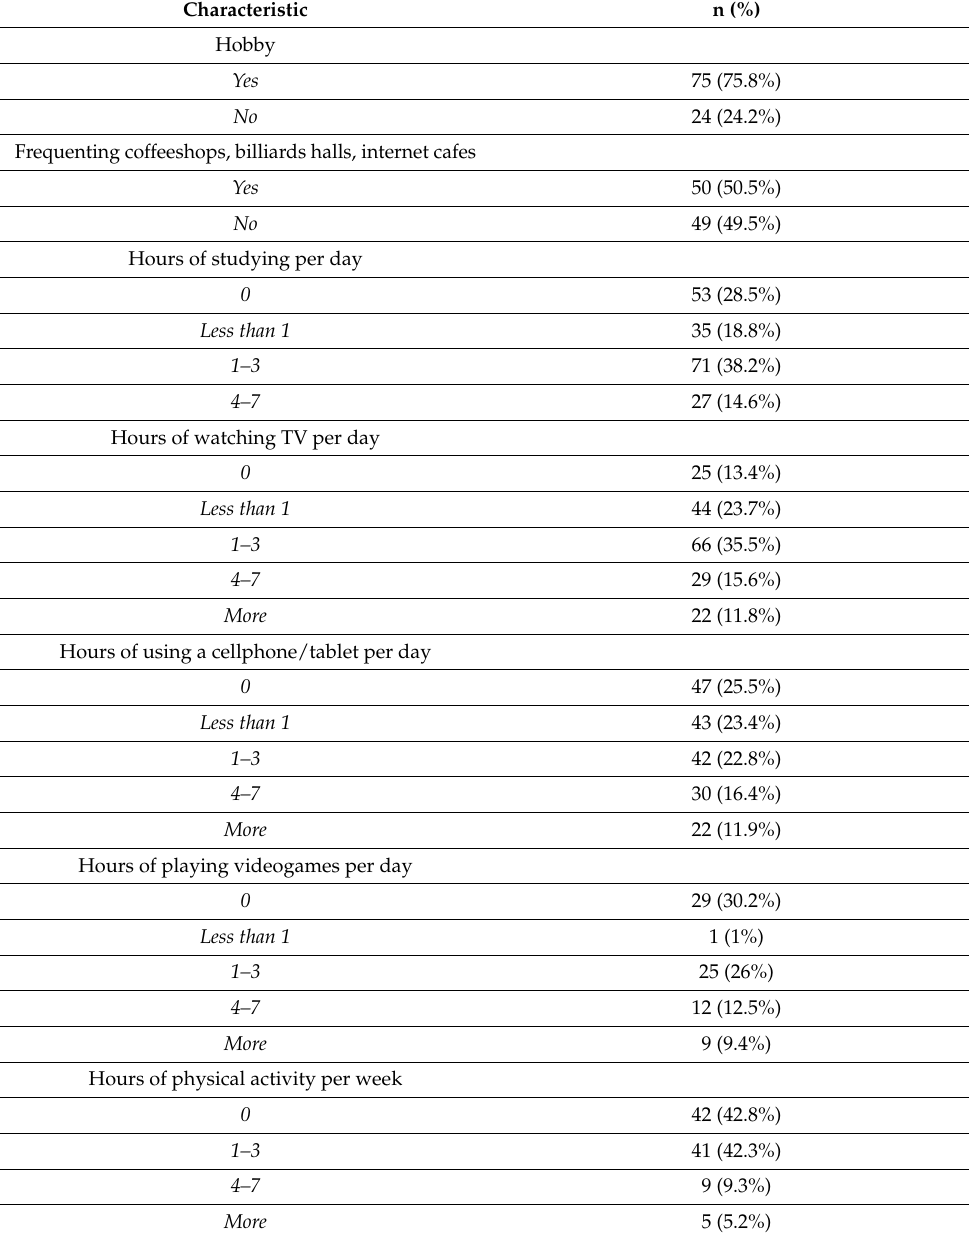
Table 3. Juvenile delinquents’ lifestyle characteristics (N =